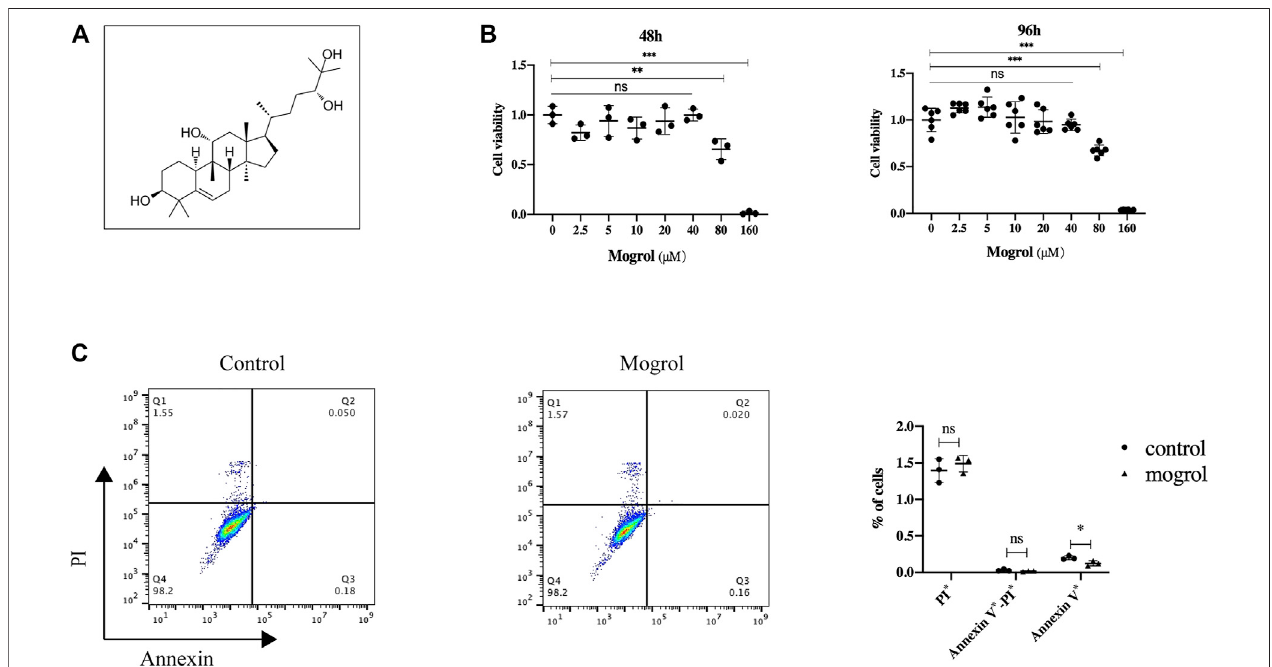
FIGURE 1 | Mogrol has no toxic effect on BMMs. (A) Mogrol ’ s chemical structure. (B) After culturing for 48 or 96 h, a CCK-8 assay was conducted to study the impact of mogrol on BMM proliferation ( n = 6). (C) Flow cytometry was utilized to analyze apoptosis of BMMs treated with 20 μ M mogrol for 48 h. The histograms show the percentages of apoptotic and dead